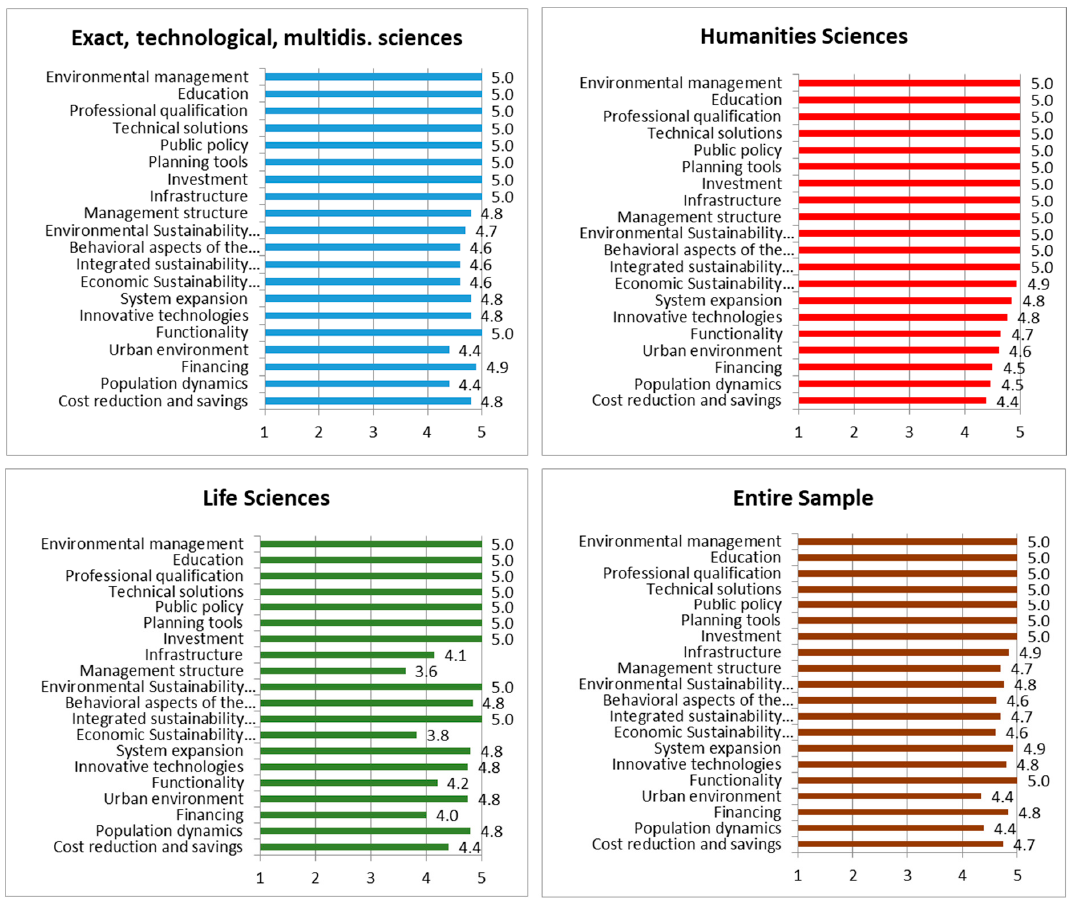
Figure 4. Drivers classified by the relative median for the three colleges of knowledge and total respondents.